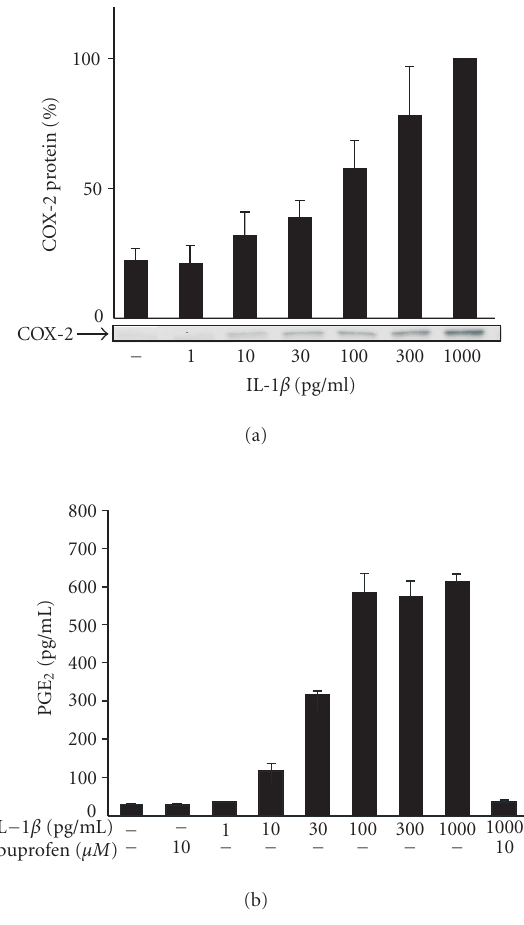
Figure 2. The e ff ects of IL-1 β on COX-2 protein expression and PGE 2 production in human T/C28a2 chondrocytes. (a) Human chondrocytes were incubated for 24 h in the presence of increas- ing concentrations of IL-1 β , and COX-2 protein was measured by Western blot. (b) Human chondrocytes were incubated for 24 h in the presence of increasing concentrations of IL-1 β , and PGE 2 concentrations in the culture medium were measured by radioimmunoassay. COX inhibitor ibuprofen (10 µ M) was used as a control compound. Mean ± SEM, n = 4 − 6. In (a), a repre- sentative gel is shown under the